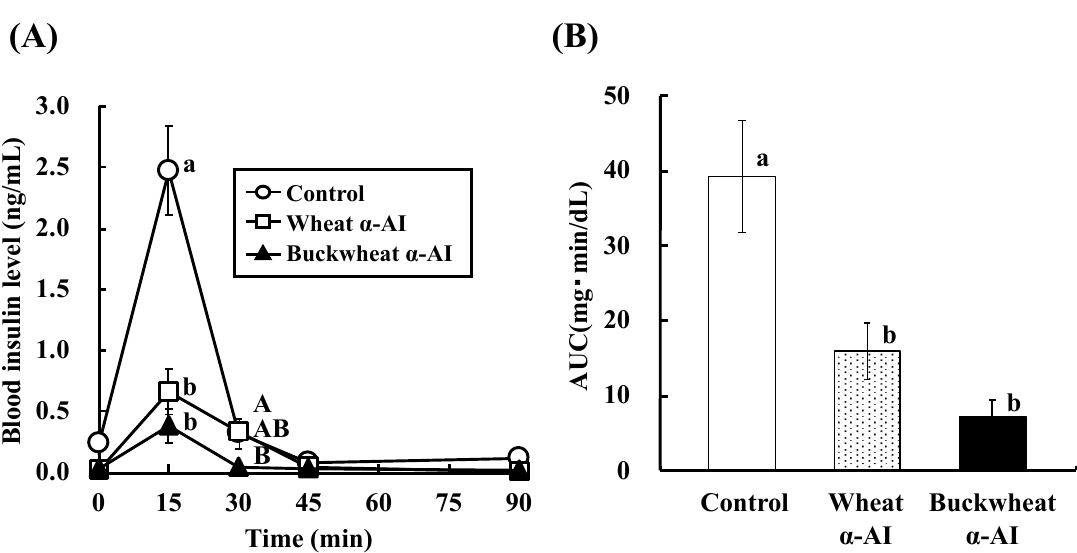
Figure 3. Effect of wheat and buckwheat α -AIs on ( A ) plasma insulin level and ( B ) insulin AUC after oral starch tolerance test using Wistar rats. Each value is the mean of seven experiments with S.E. shown as a vertical bar. Values with different letters are significantly different at p < 0.05.